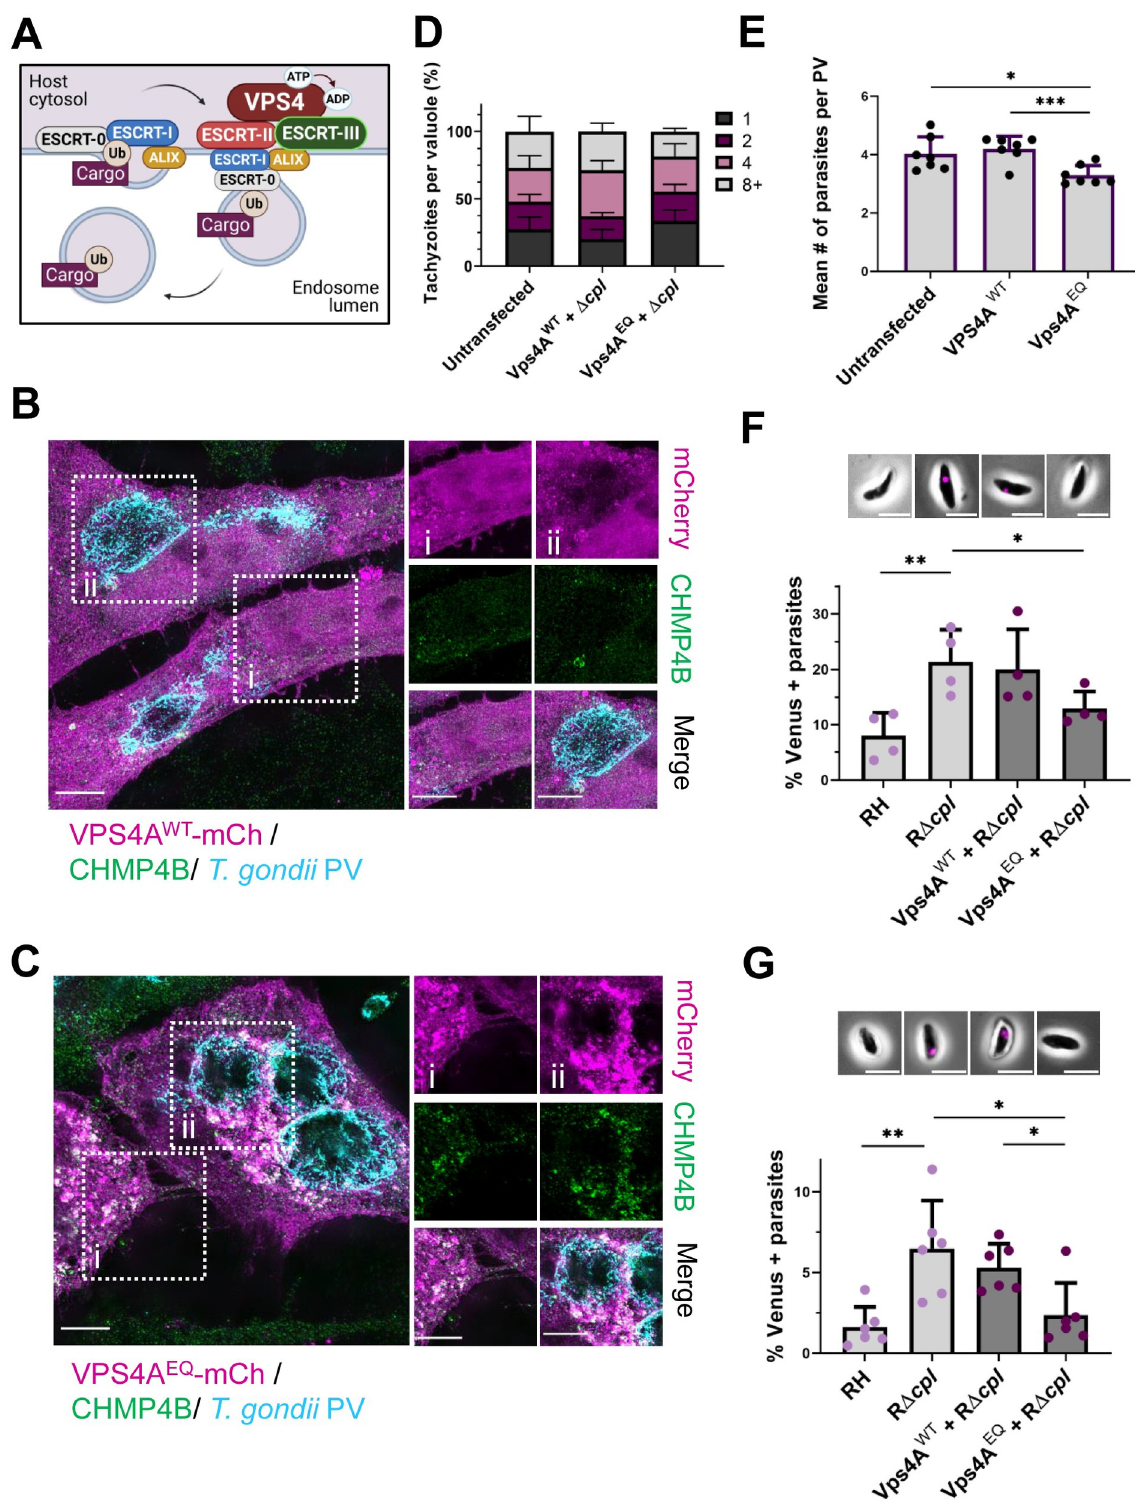
Fig 1. Disruption of the host ESCRT machinery impairs uptake of host cytosolic proteins by Toxoplasma gondii . A. Schematic of the ESCRT machinery function in MVB formation. Ubiquitinated cargo targeted for degradation is recognized by ESCRT-0 and ECSRT-I, which further recruits ESCRT-II and the ESCRT accessory protein ALIX. At the last steps, ESCRT-III forms spirals at the membrane to mediate